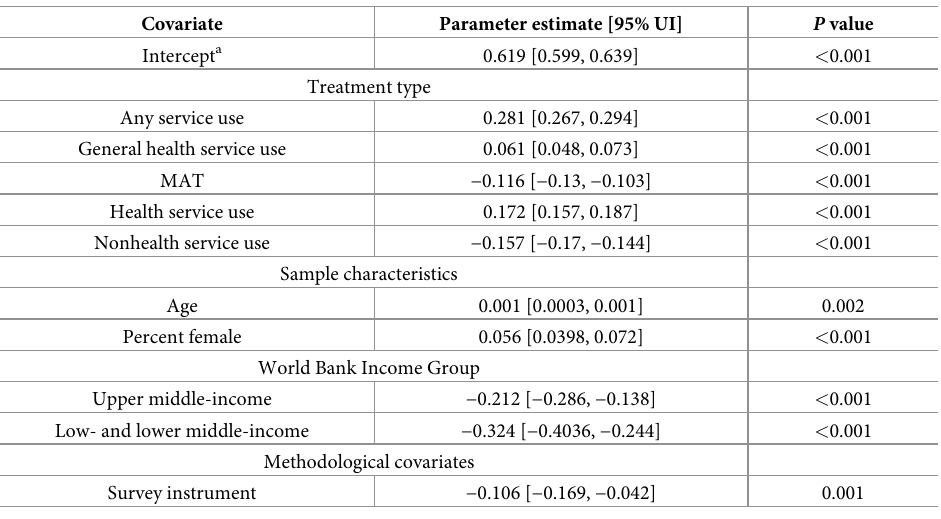
Table 4. Regression coefficients and 95% UIs for MDD treatment rates modeled as a function of select covariates: Treatment type (ref = mental health service use), income group (ref = high-income), age (ref = median approxi- mately 50 years), sex (ref = both), and survey instrument (ref = mental disorder diagnostic instrument).